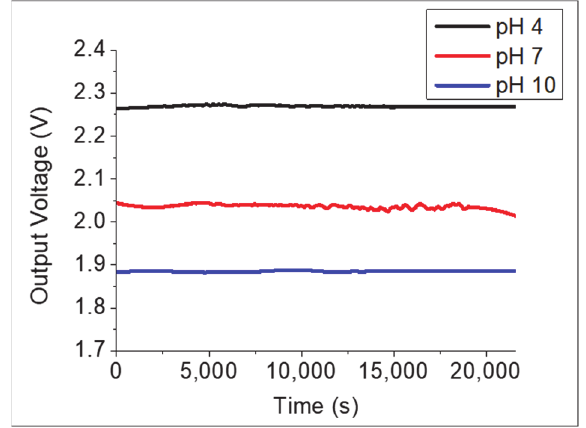
Figure 8. Drift characteristic of TiO 2 –PANI composite thin film.